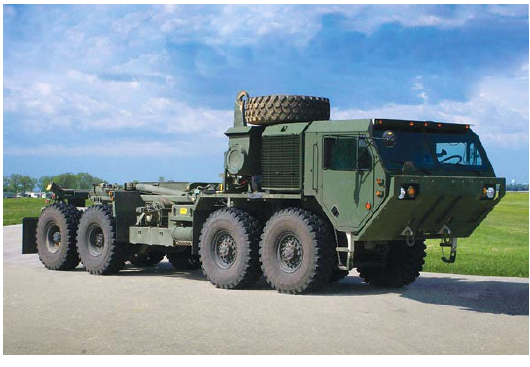
Figure 9 – Light multipurpose tactical truck (HEMTT) Рис . 9 – Многоцелевой транспортный автомобиль тактического назначения